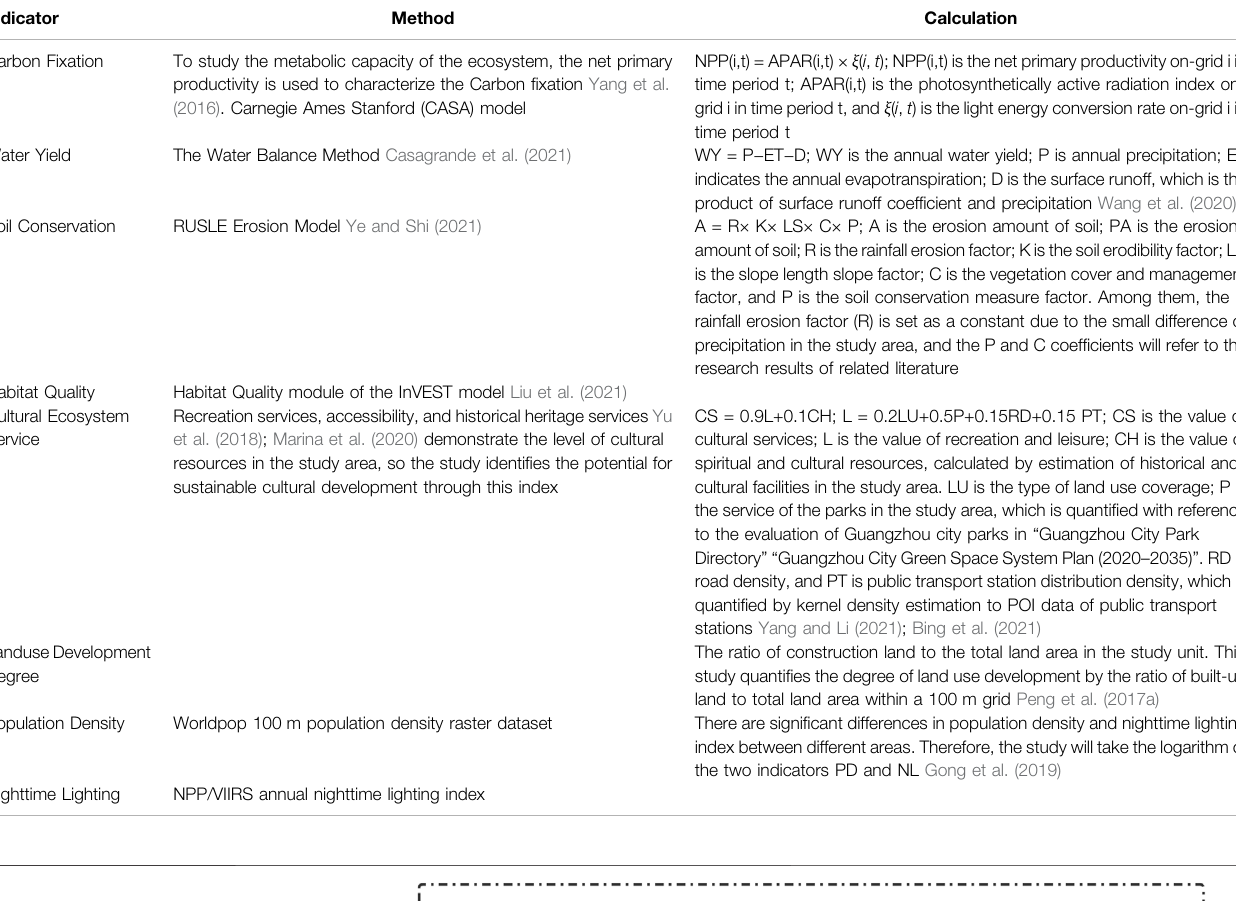
TABLE 1 | Assessment methods.